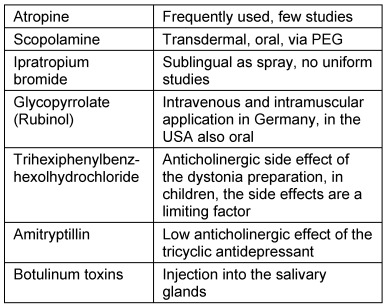
Drug therapy for hypersalivation